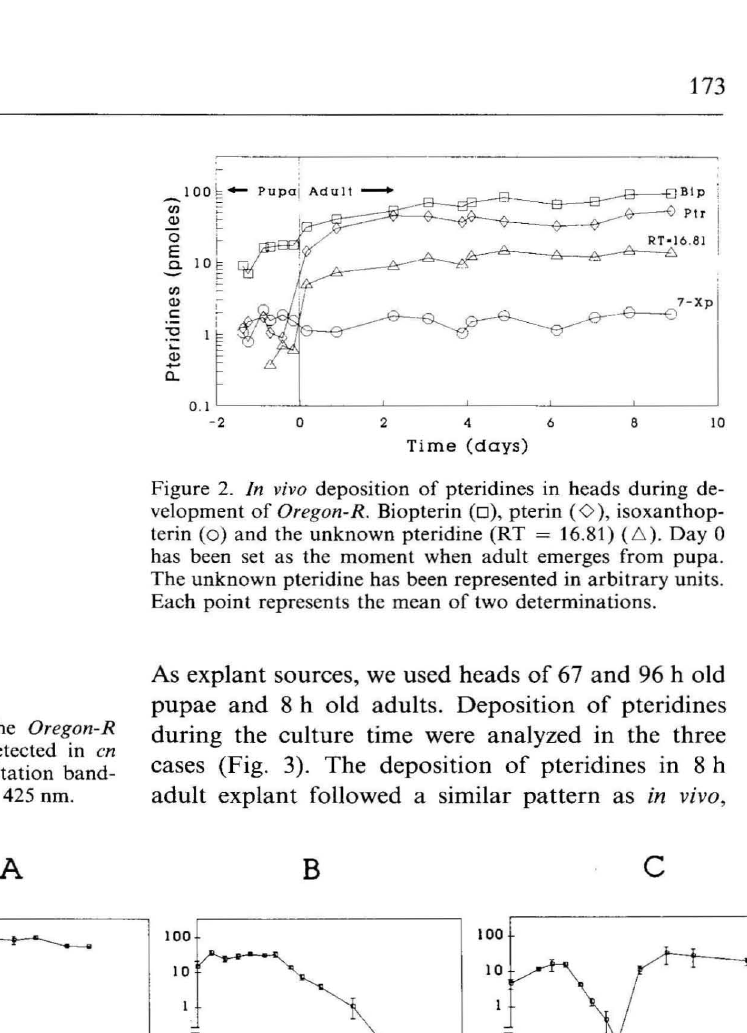
As explant sources, we used heads of 67 and 96 hold pupae and 8 h old adults. Deposition of pteridines during the culture time were analyzed in the three cases (Fig. 3). The deposition of pteridines in 8 h adult explant followed a similar pattern as in vivo,